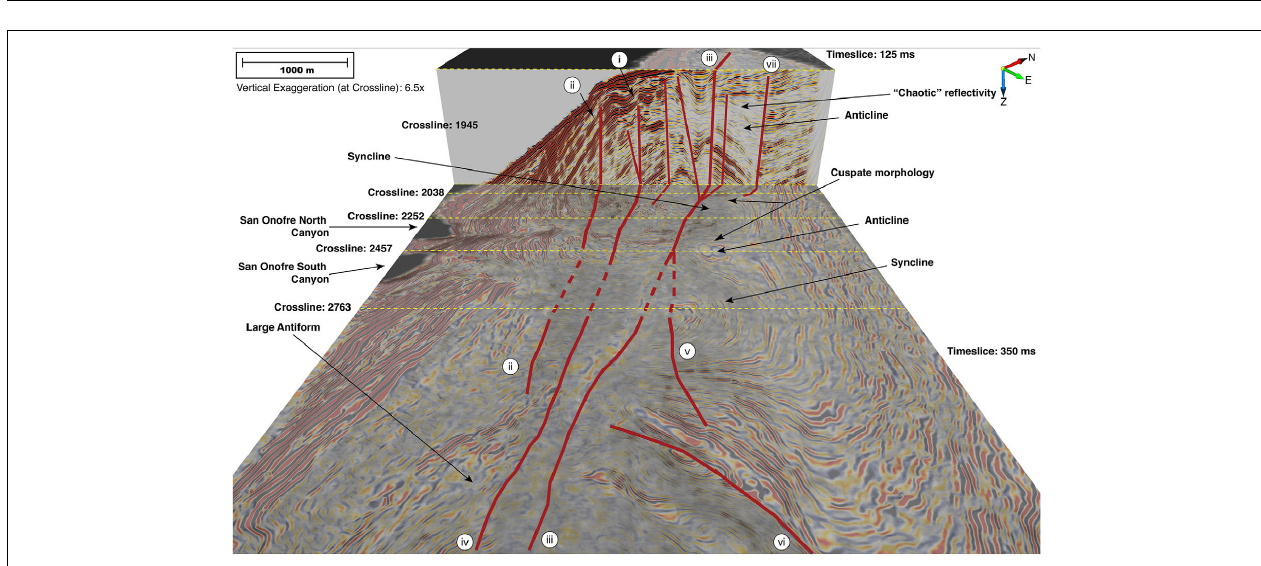
FIGURE 4 | Stair diagram of crossline 1945 with interpreted faults displayed using solid red lines. Location relative to the survey area, is shown in Figure 1C . Fault interpretations with more uncertainty are shown as dashed red lines in lower (350 ms) time-slice. Much of the minor faulting and deformation shown is bounded between fault segments ii and iii along the outer shelf edge. In the crossline, deformation between fault segments iii and vii is narrower than in Figure 3 , as the plane of fault segment viii moves closer to splays of segment iii. Segment iii represents the main fault plane and is the only plane shown that extends upward past the upper (125 ms) time-slice.